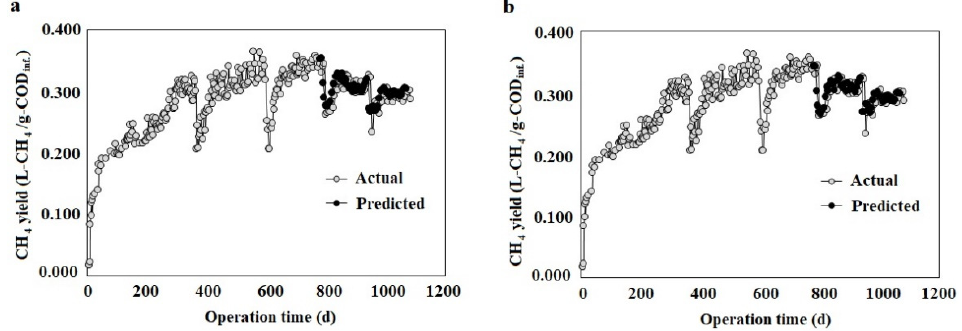
Figure 6. Results of multi-step ahead ( a ) and 1-step ahead ( b ) prediction of bio-electrochemical anaerobic digestion (BEAD) reactor using recurrent neural network (RNN) model with pH as a single input data.